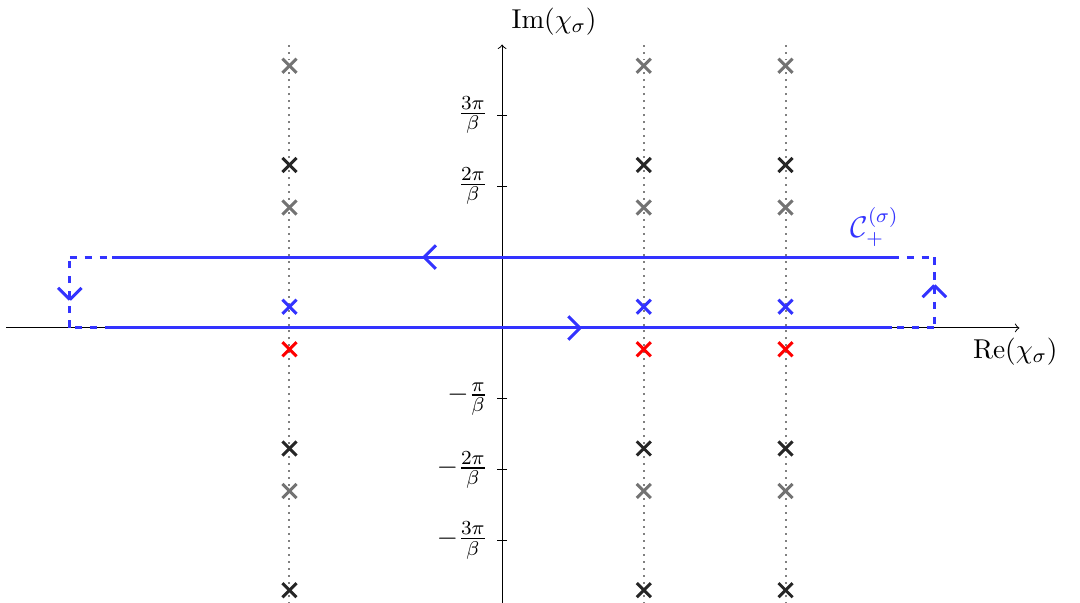
Figure 1 . For each integration variable (cid:31) (cid:27) , the fundamental domain is the region (cid:0)1 < Re (cid:31) (cid:27) < 1 and (cid:0) (cid:25) < Im (cid:31) (cid:27) < (cid:25) . The poles in the fundamental domain are shown in colour. The contour C ( (cid:27) ) (cid:12) (cid:12) selects those poles in the fundamental domain that are in the upper half plane. In this picture we have explicitly shown the 1-instanton case for the SU(3) gauge theory at k = 1.